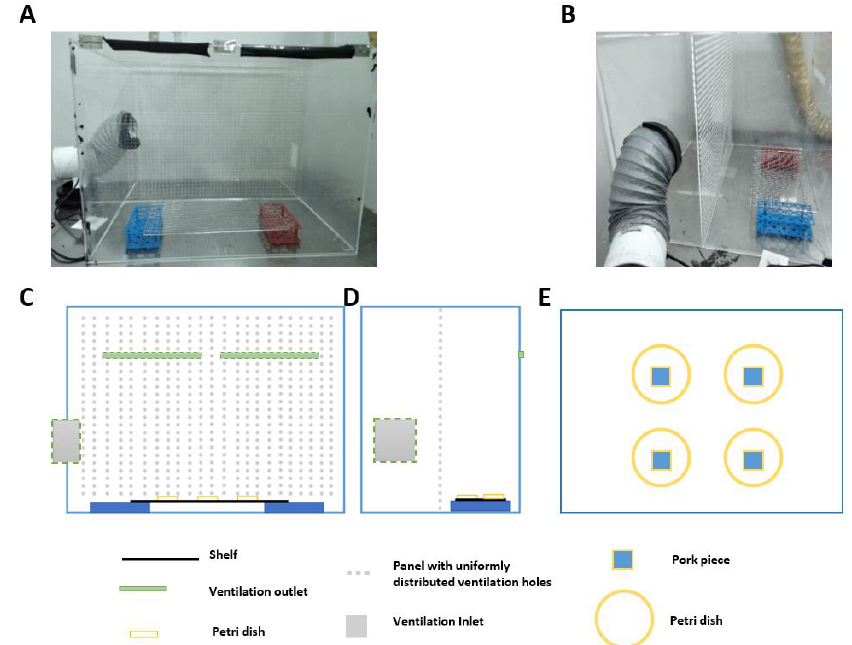
Figure 1. Cabinet working conditions. ( A ) Front view of the experimental cabinet; ( B ) side view of the experimental cabinet; ( C ) front-view diagram of the experimental cabinet; ( D ) side-view diagram of the experimental cabinet; ( E ) floor-view diagram of the experimental cabinet.